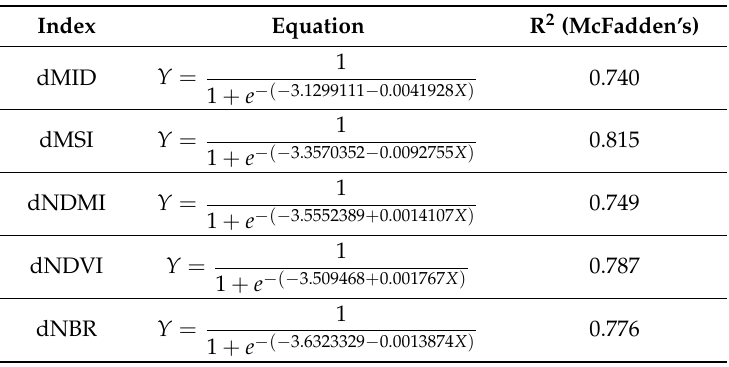
Table 4. Threshold limits and the range of vegetation indices.